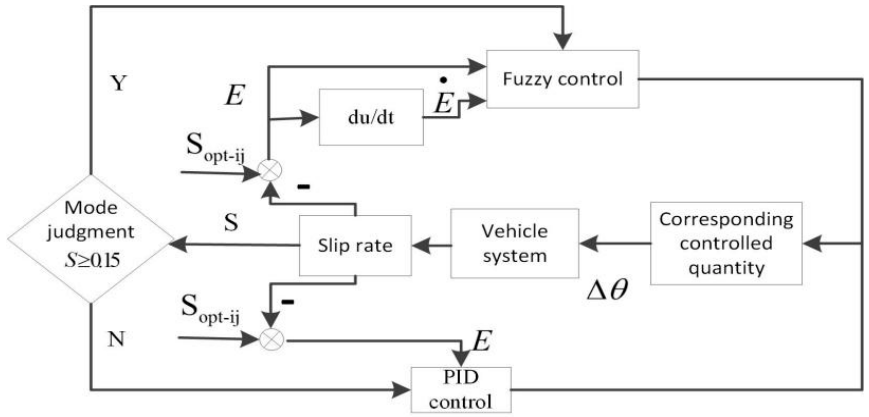
Figure 7. Block diagram of compound PID control with slip rate control.